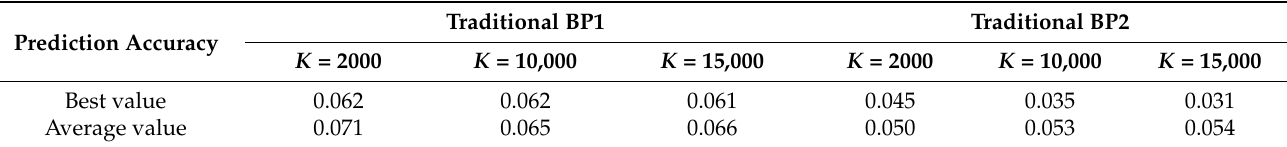
Table 4. Influence of grinding wheel wear features on prediction results.